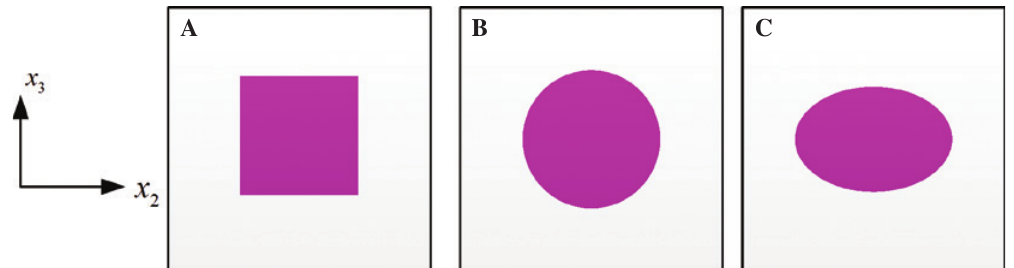
Figure 12: Composite RVE with (A) square, (B) circular and (C) elliptical